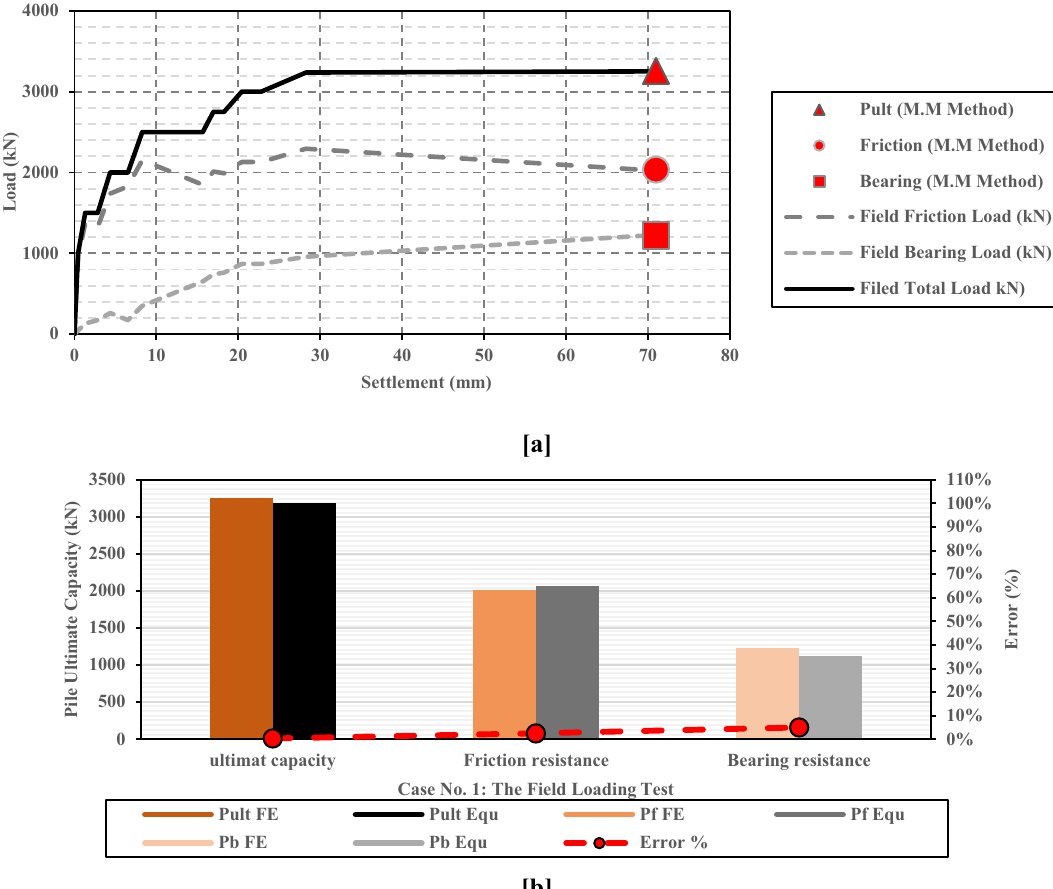
Figure 15. Comparison between the calculated pile friction resistance, bearing resistance, and the ultimate capacity using the modified approach and the in-situ measurements of the case history 36 . ( a ) Load-settlement relationship ( b ) Ultimate pile